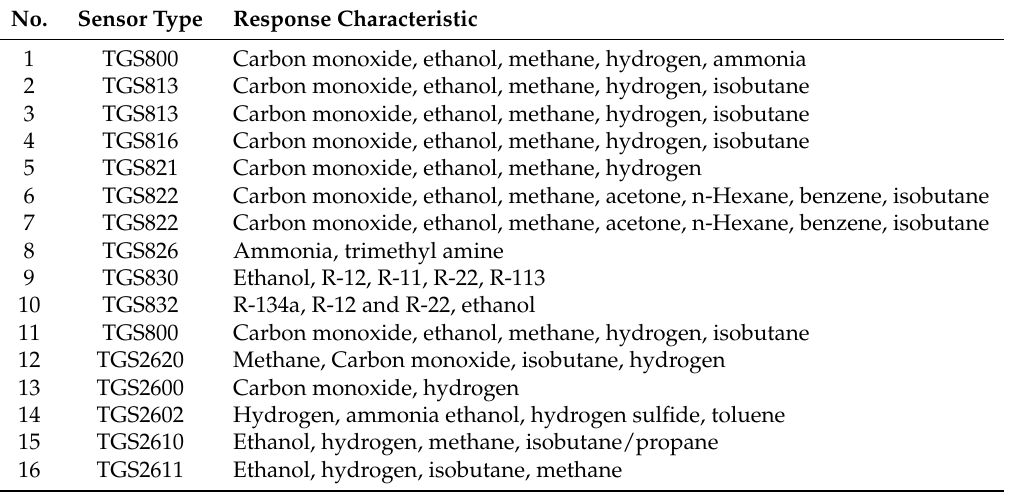
Table 2. The response characteristics of